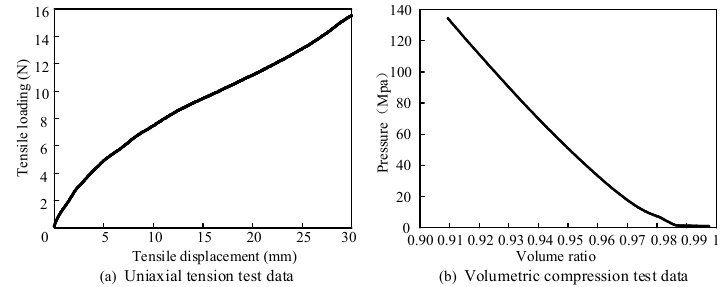
Figure 8. Test data of the flexible joint rubber.